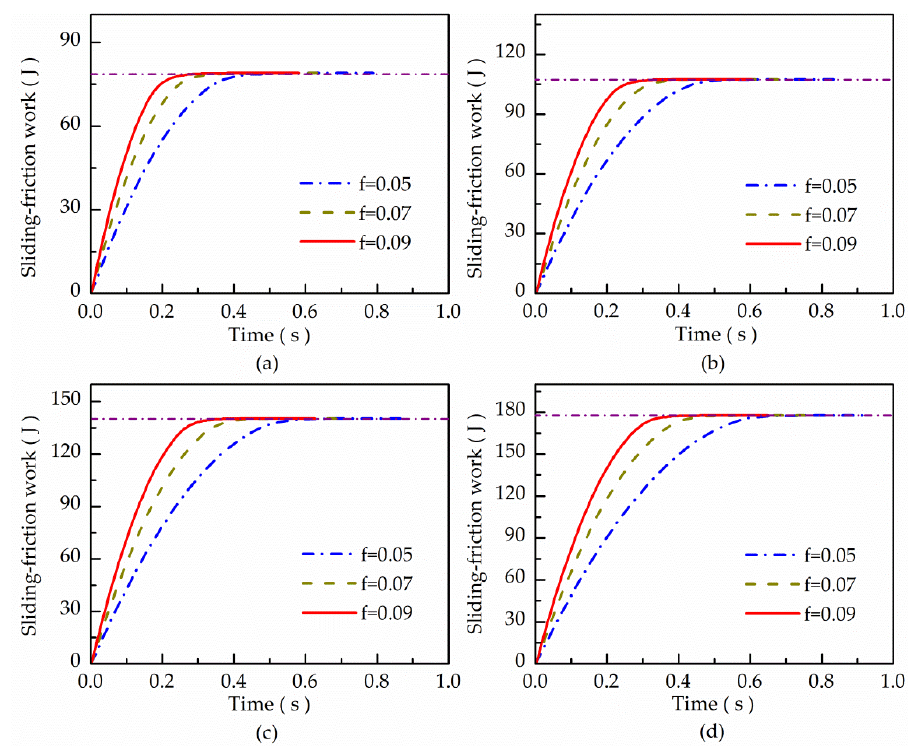
Figure 3. Sliding-friction work contrast: ( a ) shift speed difference 600 r/min; ( b ) shift speed difference 700 r/min; ( c ) shift speed difference 800 r/min; ( d ) shift speed difference 900 r/min.